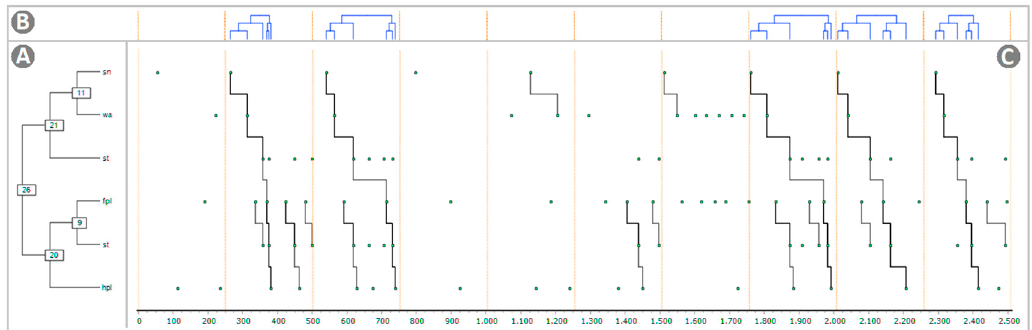
Figure 3. Visualization of the longest T-pattern detected in both groups, as provided by Theme software. ( A ) Static detection tree, that is, the level-by-level detection of the currently selected pattern; each terminal event is aligned with its occurrences, indicated by dots in ( C ) - numbers in boxes are identification codes of the selected pattern and lower level sub-patterns; ( B ) Dynamic detection tree, that is, the same tree structure presented in ( A ) but rotated so that each terminal is temporally synchronized and aligned with the events (dots) reported in the connection diagram below; ( C ) Connection diagram, that is, events (dots) connected by means of lines forming the recurrent pattern; X-axis = time in milliseconds. For abbreviations, see Figure 1.